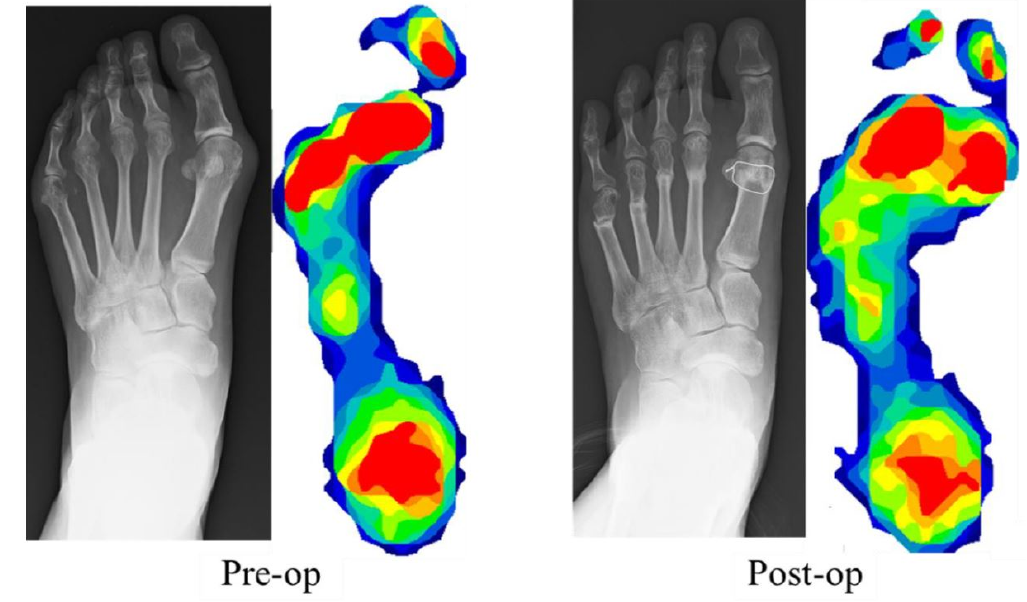
Figure 3. Preoperative and postoperative anteroposterior radiographs and plantar pressure distribution images of a repre- sentative case. Peak pressure increased at the first metatarsophalangeal joint (0.008 kg/cm 2 vs. 0.094 kg/cm 2 ) and decreased at the second and third metatarsophalangeal joints (0.156 kg/cm 2 vs. 0.092 kg/cm 2 , 0.165 kg/cm 2 vs. 0.076 kg/cm 2